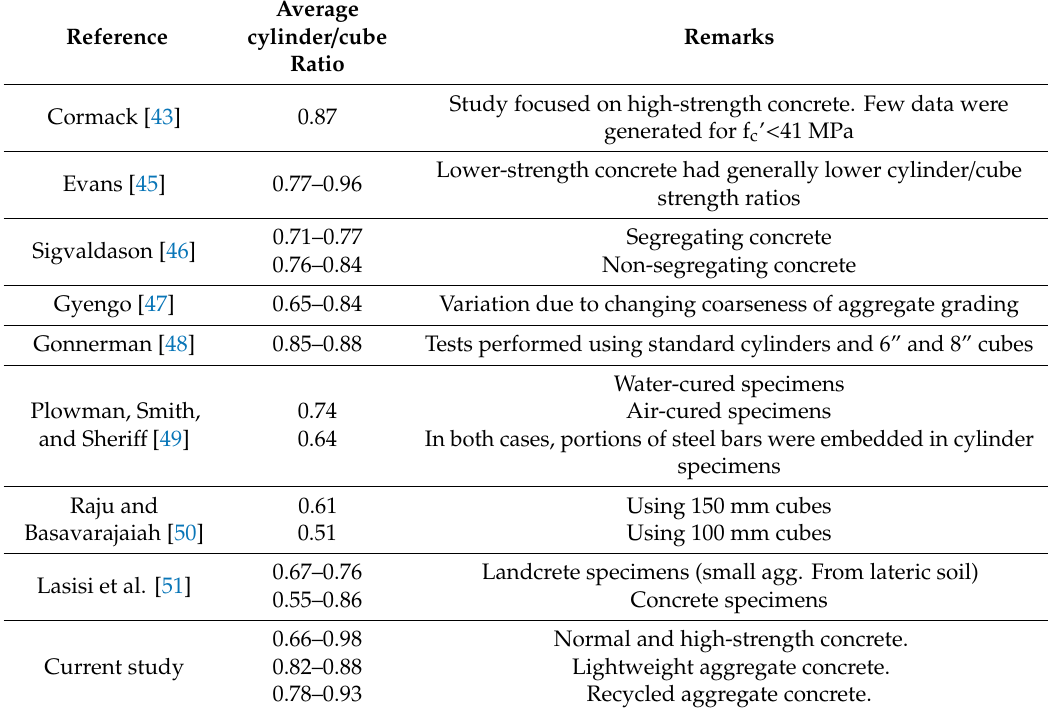
Table 9. Summary of cylinder vs. cube strength ratios from the literature compared to the current study.